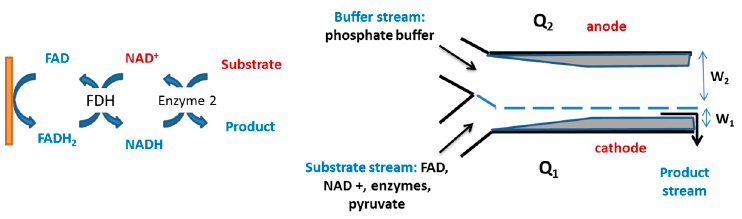
Figure 4. Schematic diagram of a laminar Y-shaped microreactor used for the electrochemical regeneration of NAD + using formate dehydrogenase (FDH) [142] .